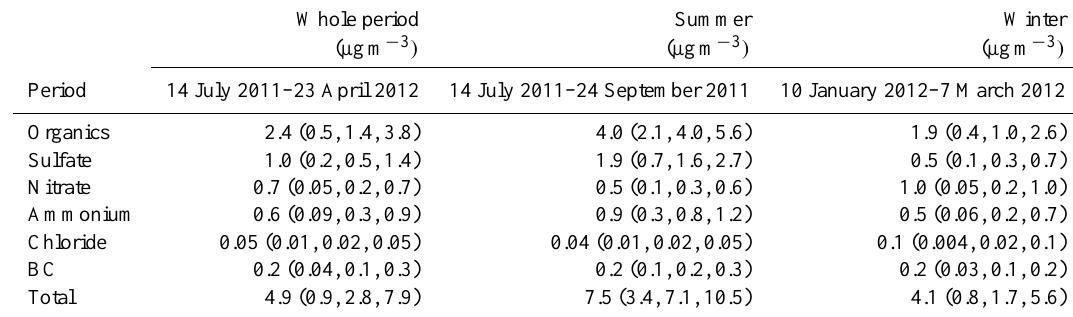
Table 1. Diurnal variation of the boundary layer height (computed with HYSPLIT model) averaged for each month during the study period at Montsec. Variation bars indicate ± standard